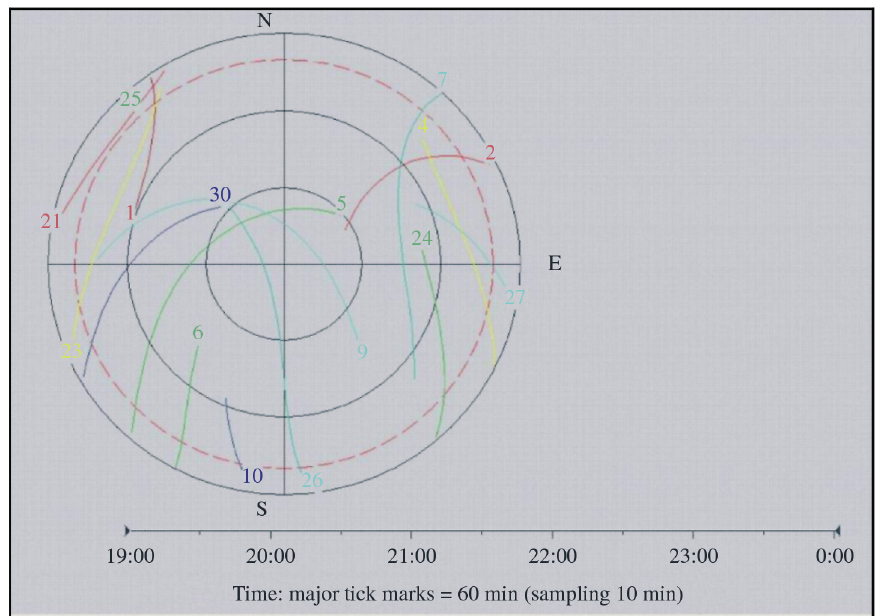
Fig. 5. Sky-Plot of available satellites for the 10/09/1997